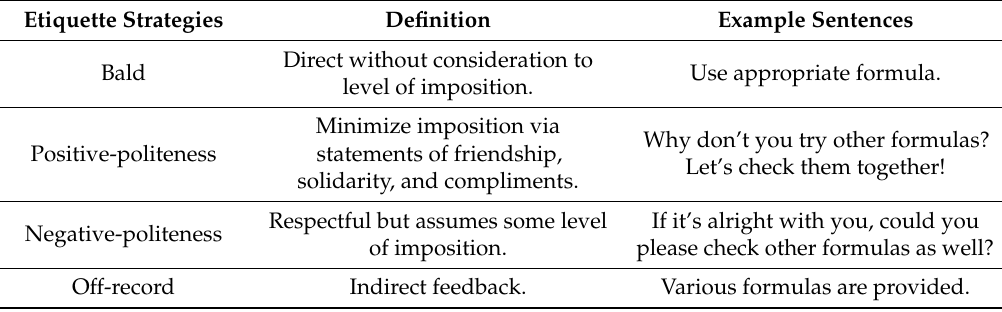
Table 1. Example sentences of etiquette strategies.